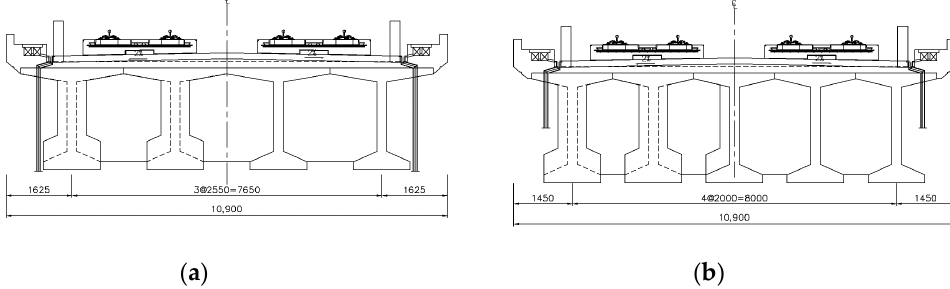
Figure 3. Longitudinal plan of railway bridge applying the new type of PSC I-girder.